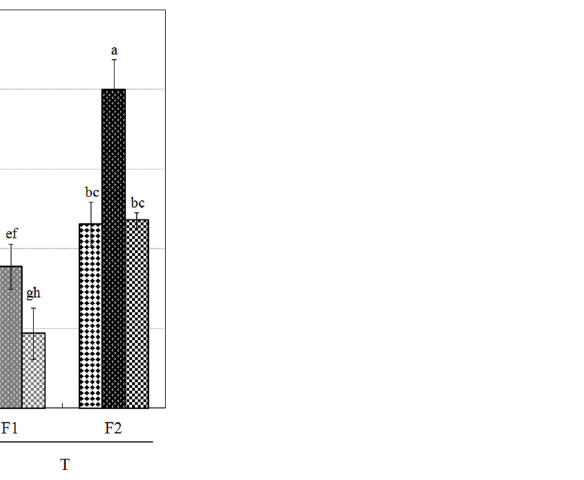
Fig 4. Final EC SSE measured at two substrate depths (T: top; B: bottom), under two fertilization rates (F1, F2) for PS25 (diamonds), CF (circumflex) and AB (squares). Each point is the mean (n = 3) with SD. Significant P-values for fertilization (F), depth (D) and substrate (S) effects are reported as follows: ( * ) = P < 0.05; ( ** ) = P < 0.01; ( *** ) = P < 0.001. Significant levels of the post hoc test results are indicated by